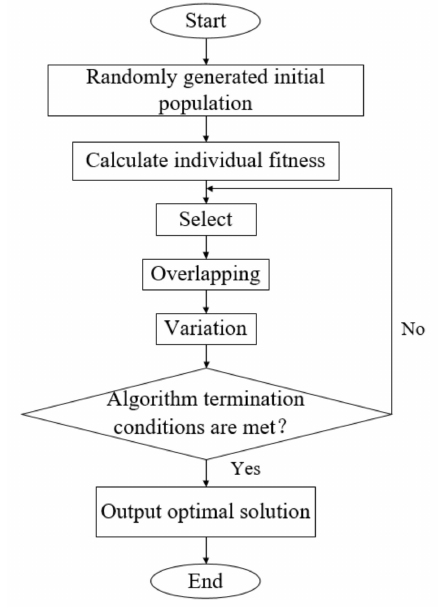
Figure 20. Flow chart of the genetic algorithm.